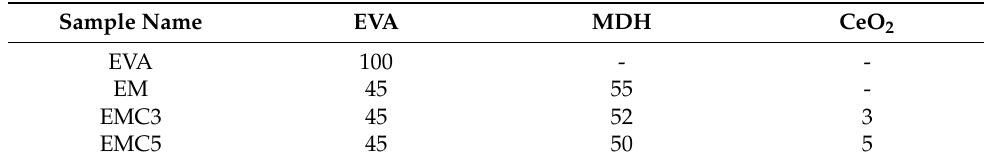
Table 1. Formulations of EVA Composites (in